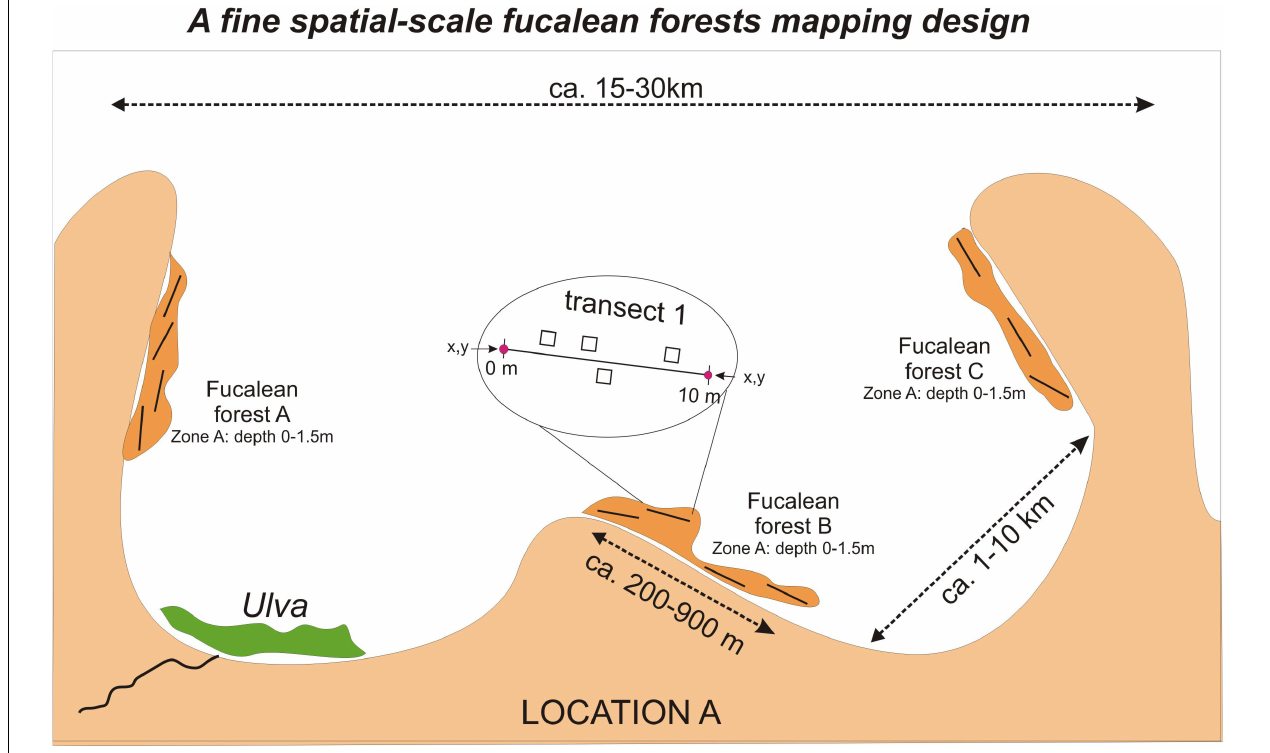
FIGURE 2 | Scheme illustrating the random nested sampling design on a hierarchy of three spatial scales (transect, meadow, and location) used to study fucalean forests percentage cover and frequency. TABLE 1 | Sampling design used for fucalean forests abundance and frequency estimations. G_OCEM: Open coasts Eastern Macedonia, Greece; G_OCCM: Open coasts Central Macedonia, Greece; I_ANC: Conero Riviera—Ancona, Italy; I_GNI: Gulf of Naples, Italy; AL_SZK: Sazan Karaburuni MPA—Sazan, Albania; S_MNRC: